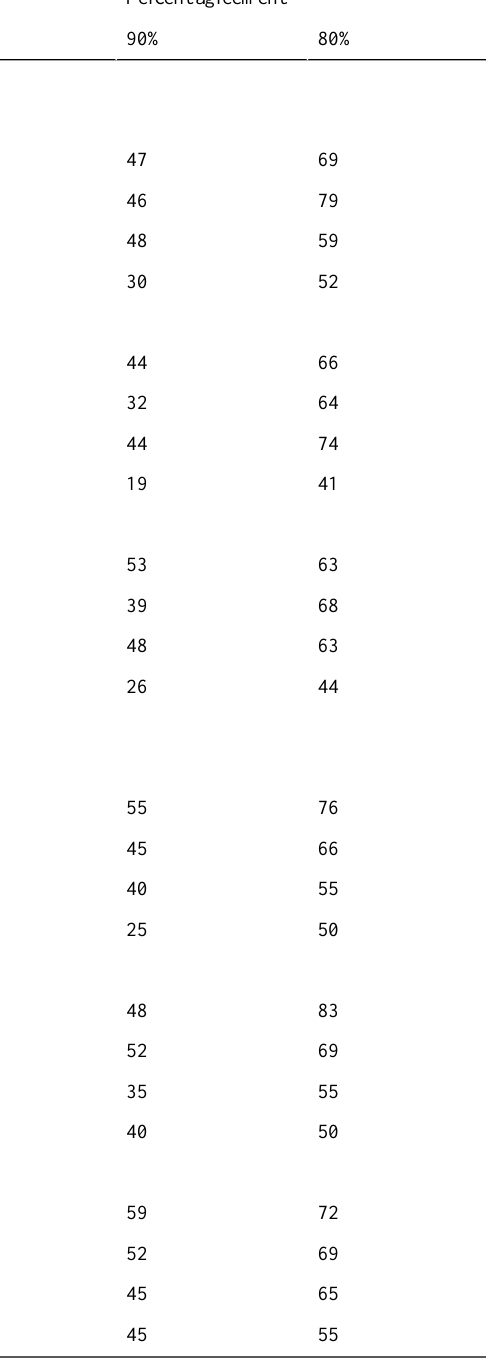
Percent agreementEnergy, protein and